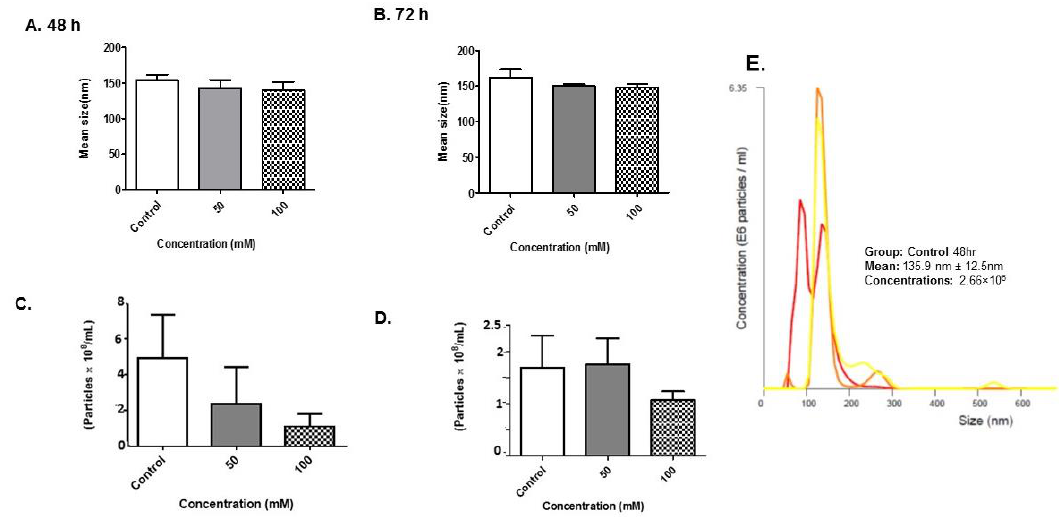
Figure 4. Nanoparticle tracking analyses validation of BV-2-derived exosomes. NTA-generated ( A , B ) size and ( C , D ) concentration of vesicles obtained from five independent experiments after EtOH administration. ( E ) Histogram plot of control exosomes collected at 48 h. The di ff erent colored lines represent di ff erent pools of